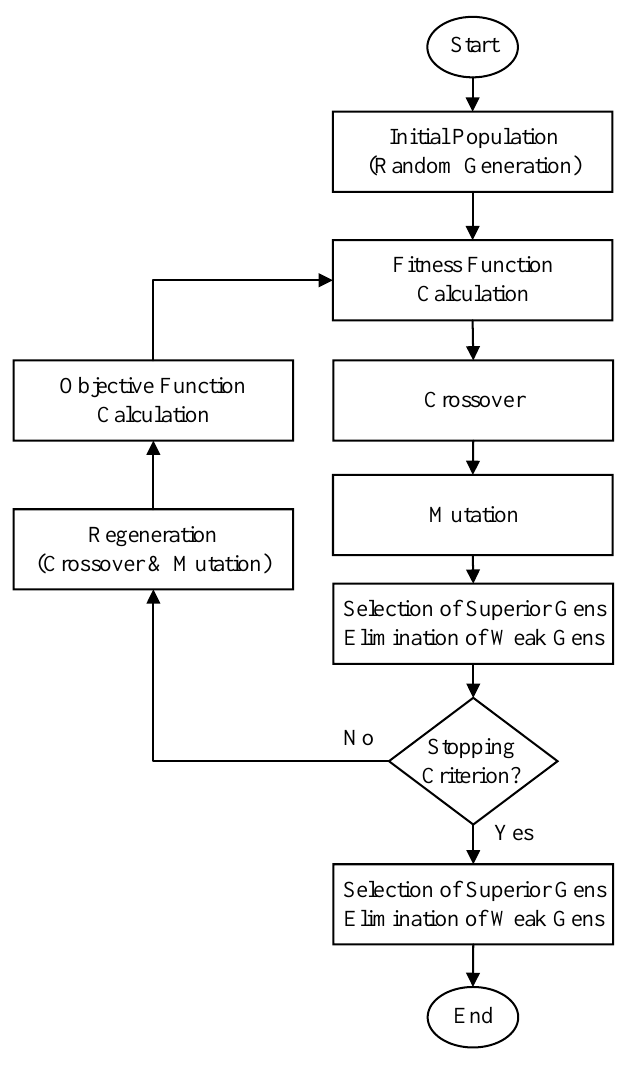
Figure 3. Flowchart of EGA